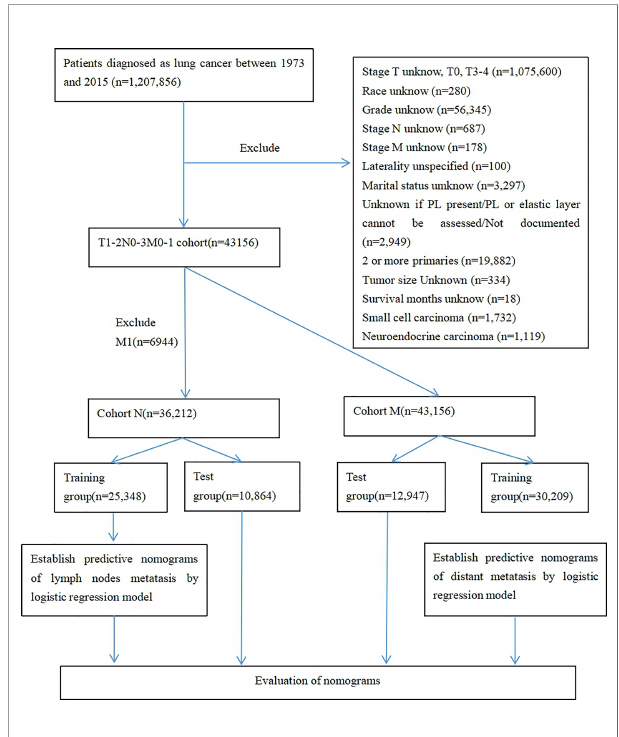
FIGURE 1 | Case screening fl ow